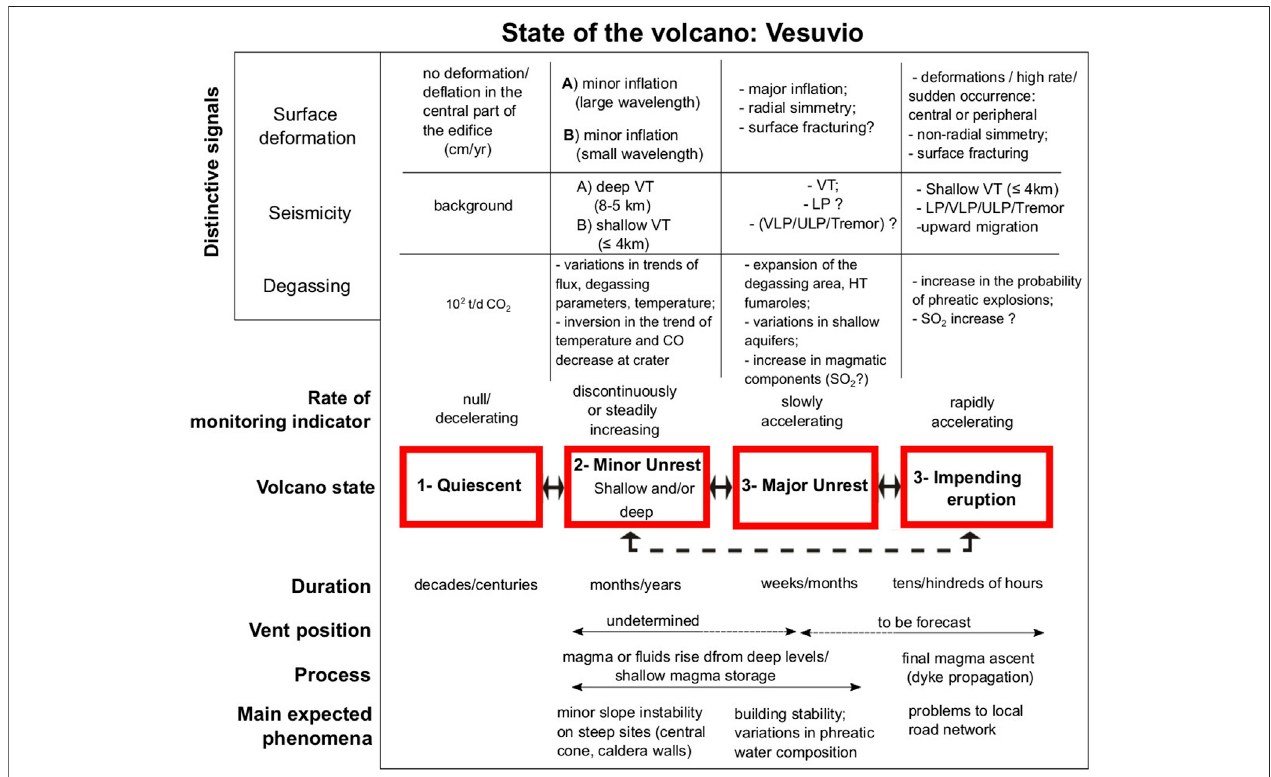
FIGURE 7 | States proposed for Vesuvio and related parameters. The reported values of the monitoring parameters suggest the most likely order(s) of magnitude for a parameter in each state, although a speci fi c state may be accompanied by a different order of magnitude. The most likely rate associated with the monitoring parameters in each state (in terms of deceleration, steady increase, slow or rapid acceleration) is also suggested.